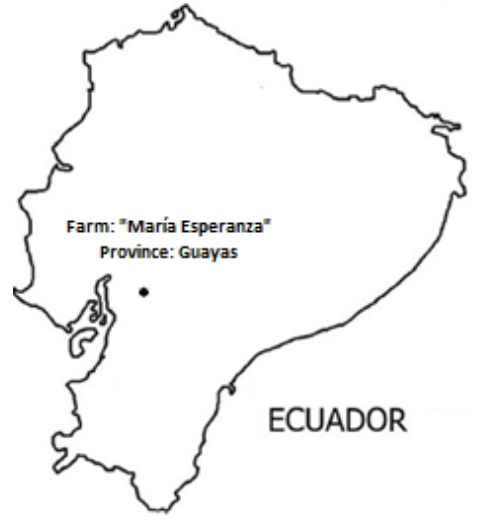
Figure 2. Sampling Farm Location .